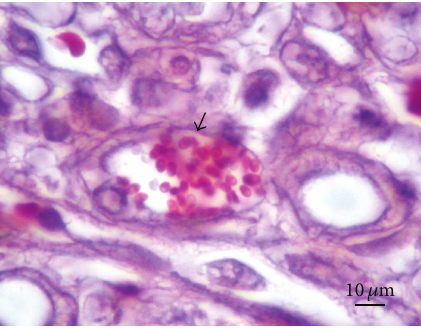
Figure 4: Kidney. Intraluminal Encephalitozoon cuniculi spores (arrow). Modified trichrome blue stain.